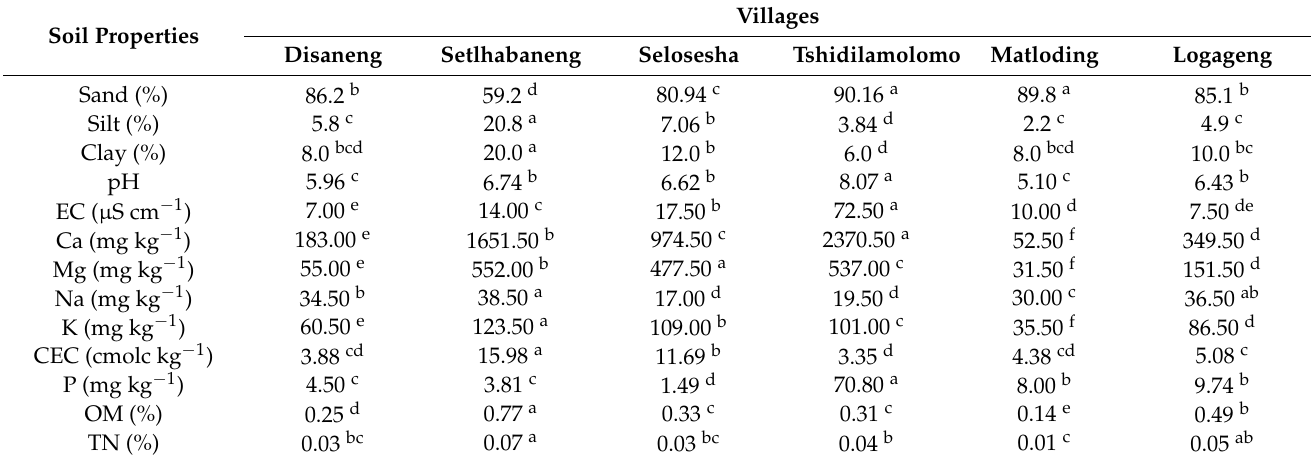
Table 3. Comparison of the mean values of soil properties obtained around the six selected